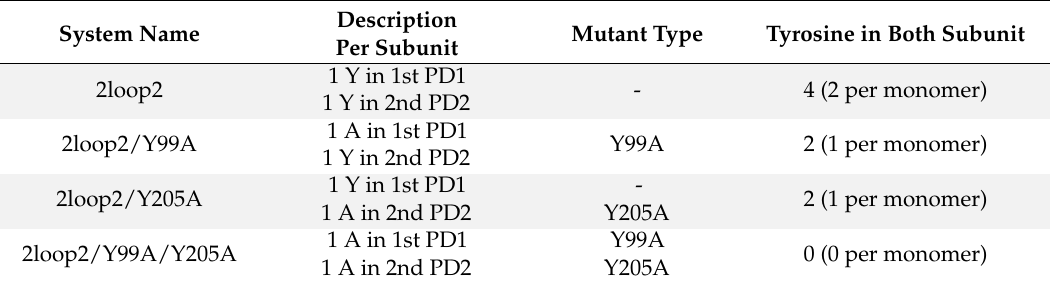
Table 1. Description for the four mutants used during the